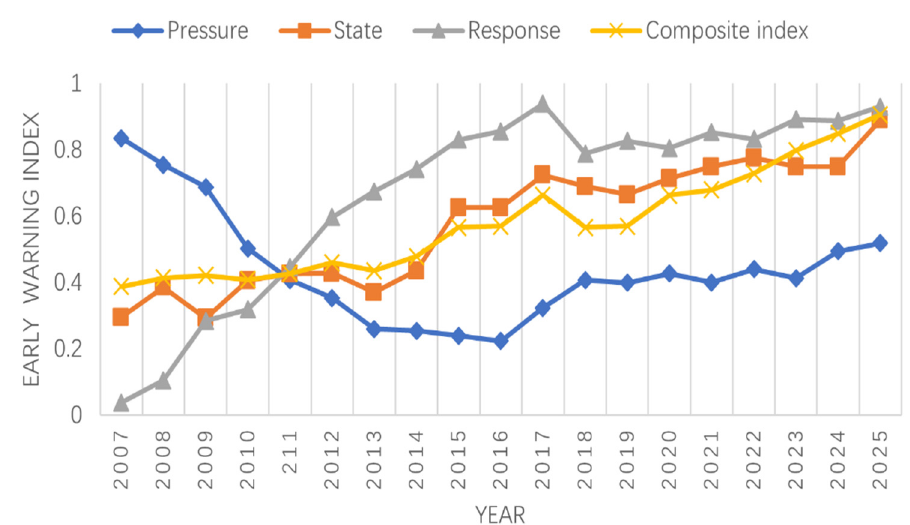
Figure 5. Evaluation results for the TEH in Henan Province from 2007 to 2025.